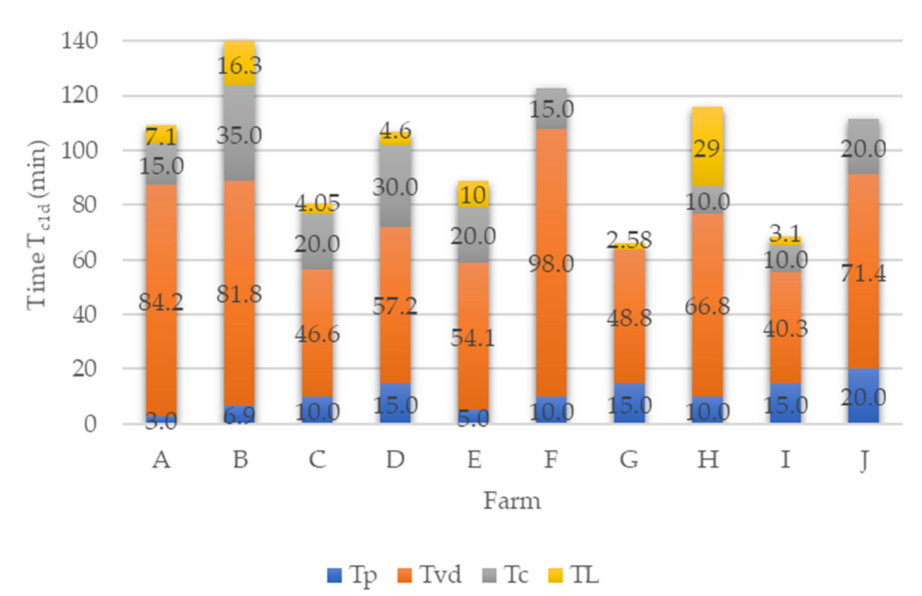
Figure 3. Current real time of a single milking T c1d (min) at all analyzed dairy farms ( T p —the time of preparatory work before milking, min; T vd —the real time of all groups of goats spent in a milking parlor min; T c —the time of finishing and cleaning work after milking, min; T L —accessory times, min).